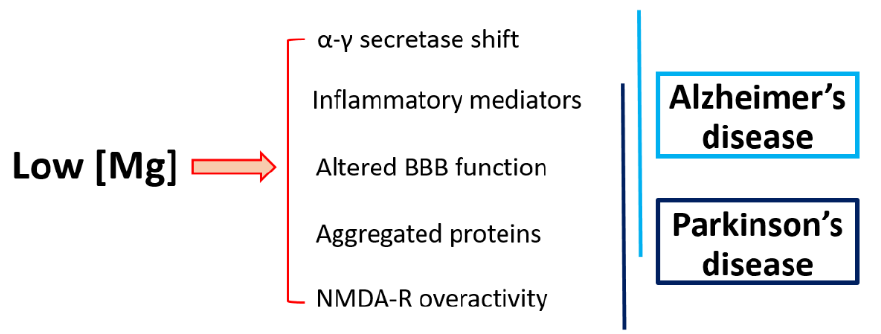
Figure 3. Low Mg in Alzheimer’s and Parkinson’s diseases. Magnesium deficiency promotes common events involved in Alzheimer’s and Parkinson’s diseases.